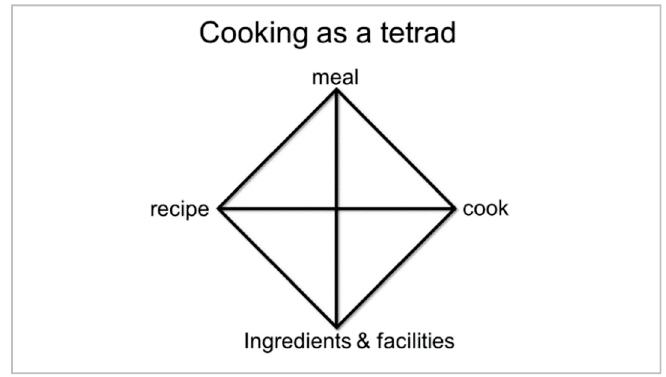
Figure 2. Cooking as a tetrad [9] (pp. 63-65).